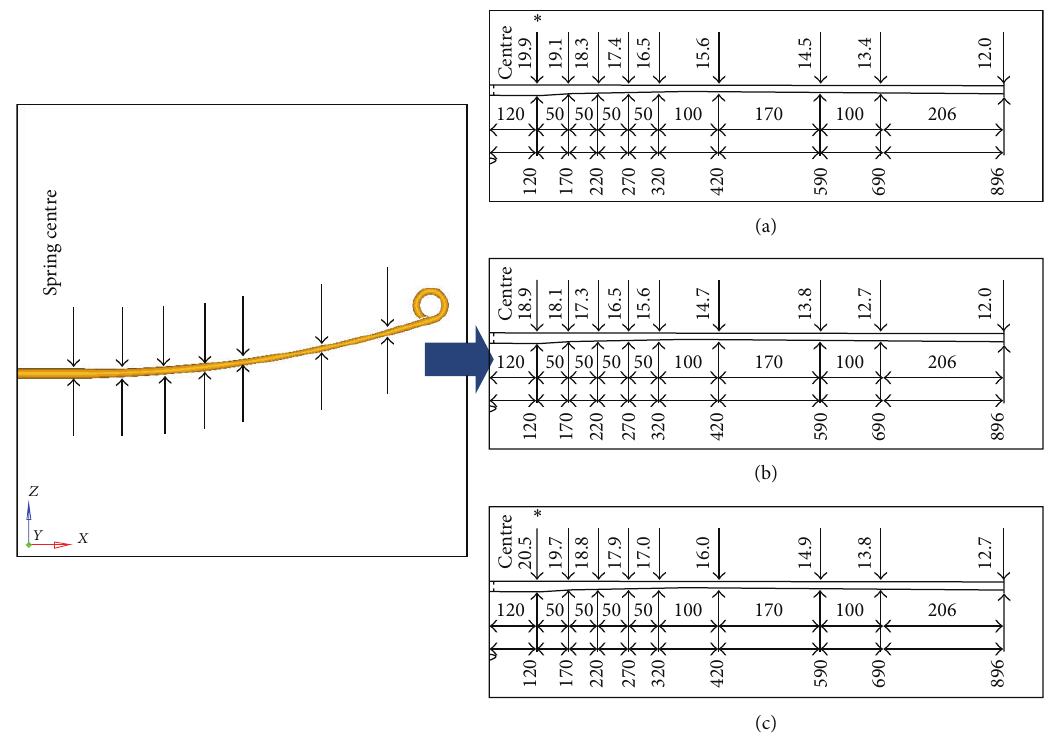
Figure 4: Taper profile of (a) Baseline, (b) Iteration 1, and (c) Iteration 2.